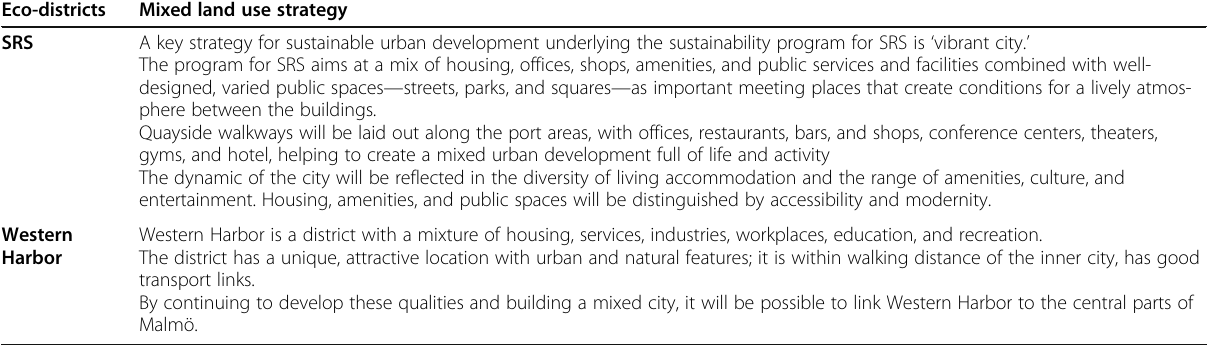
Table 5 Mixed land use dimensions in SRS and Western Harbor as eco-city districts Eco-districts